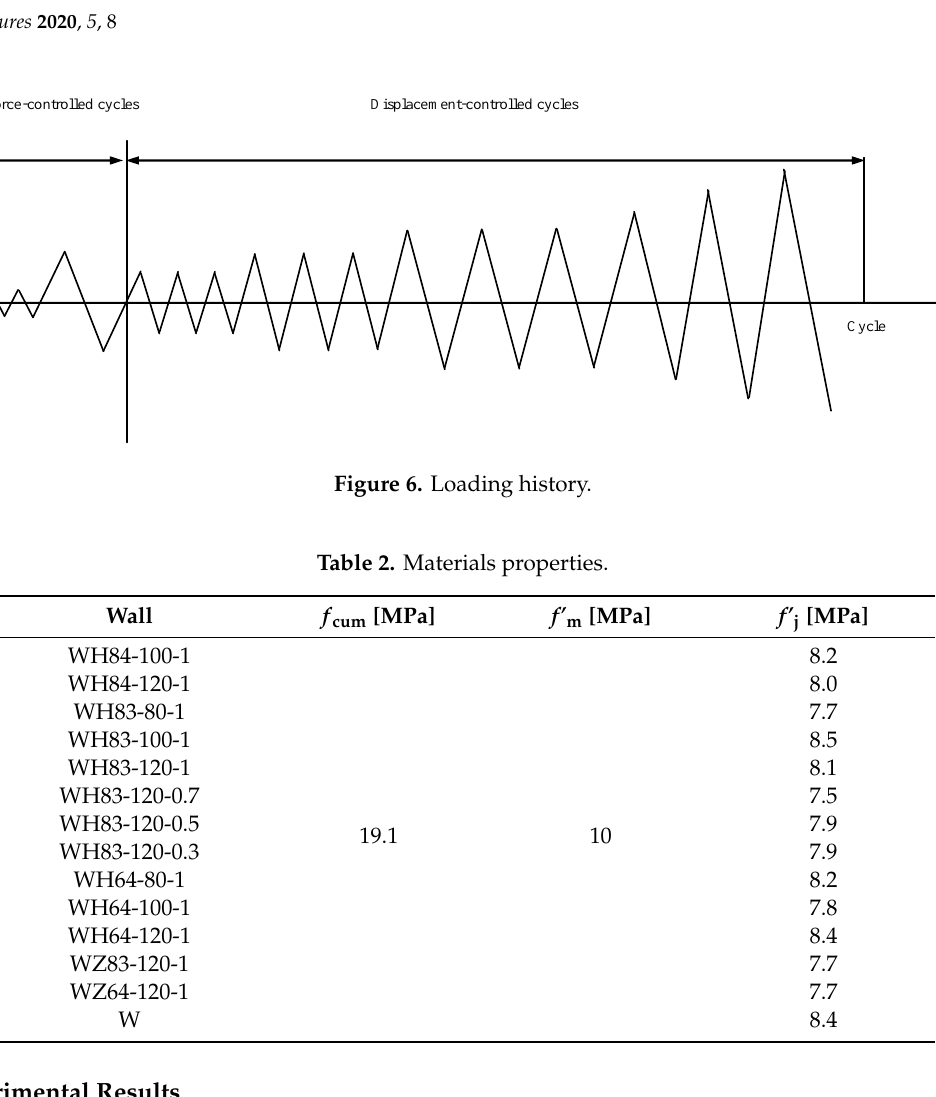
Figure 5. Load and displacement sensor arrangement (1-1,1-2. Load and displacement sensor; 2-1–2-